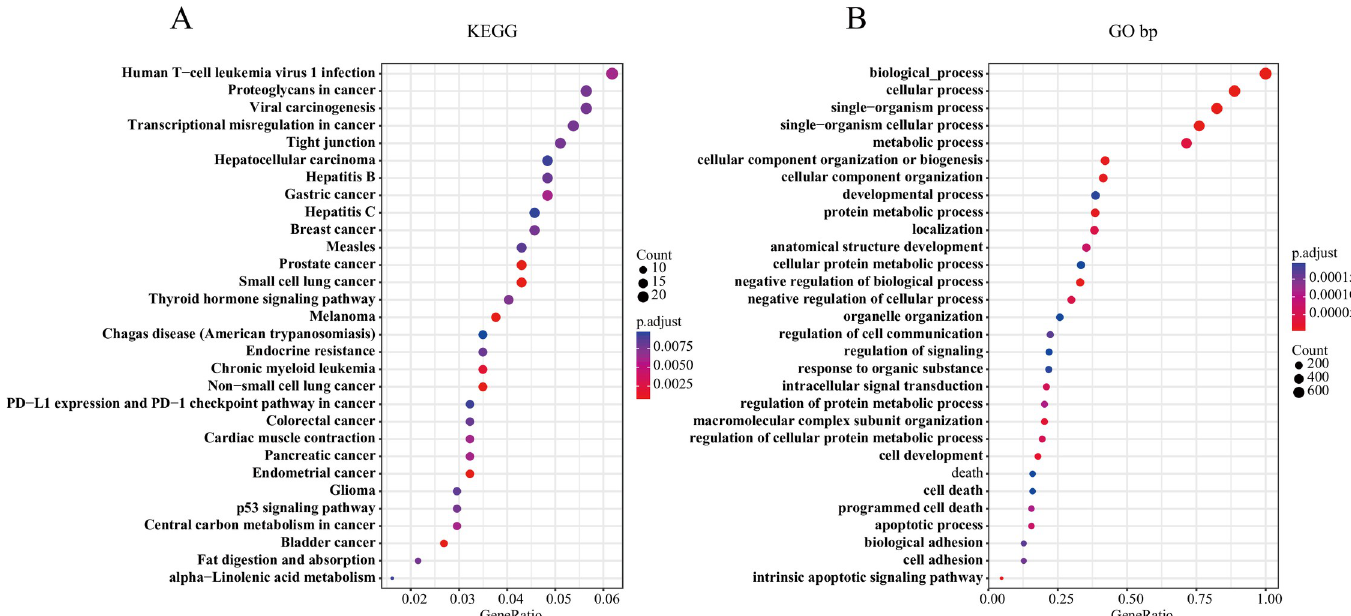
Fig 2. A: The 1021 genes with copy number variation and mutation are involved in the KEGG pathway. B: The 1021 genes with copy number variation and mutation are involved in the GO bp pathway.